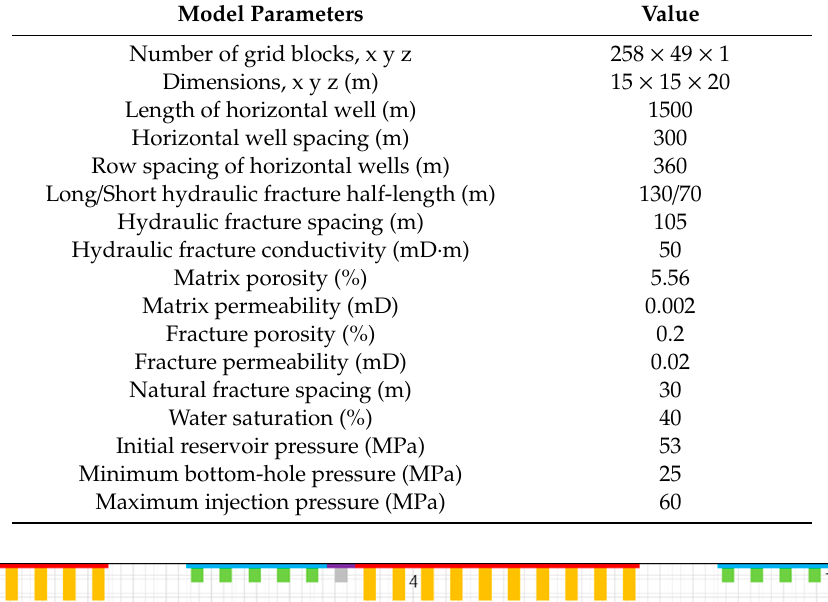
Table 3. Numerical simulation model parameters.